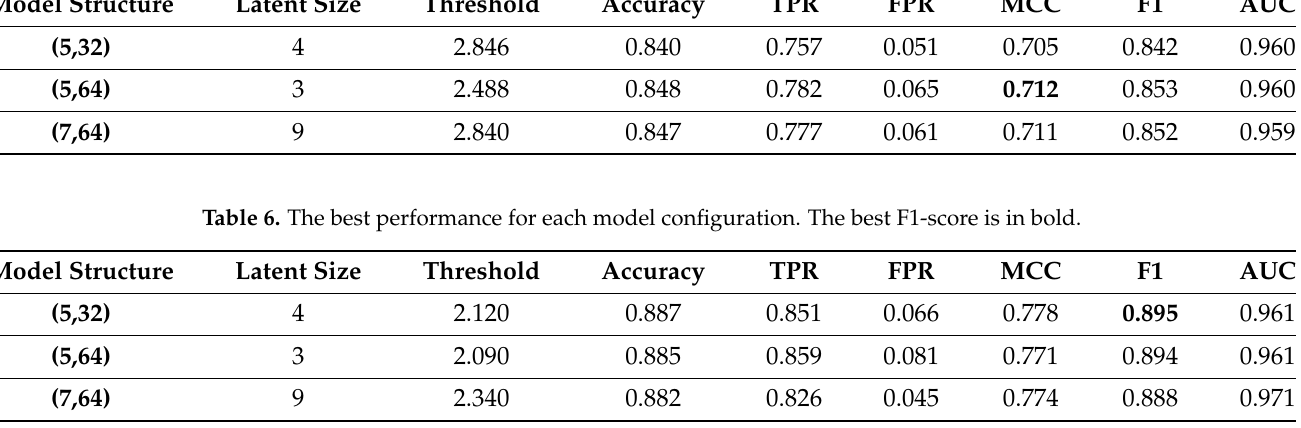
Table 5. Evaluation results with NSL-KDD. The best configuration from each model structure was chosen based on the MCC score. The reported metrics are averaged over 20 runs. The best MCC score is marked in bold. Model Structure